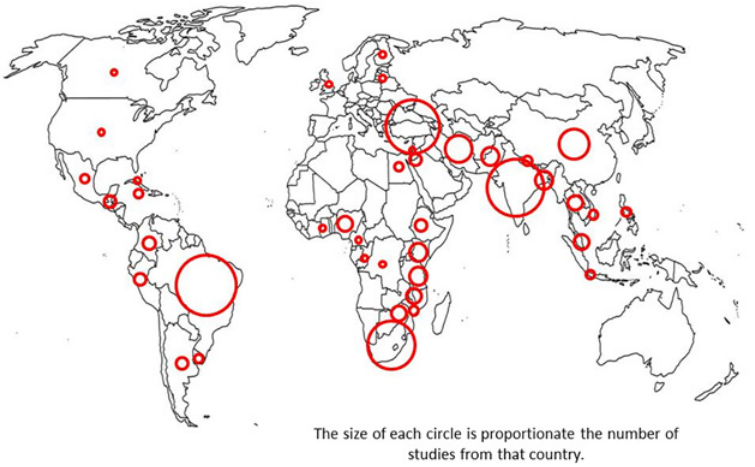
Fig 2. Geographical Distribution of Included